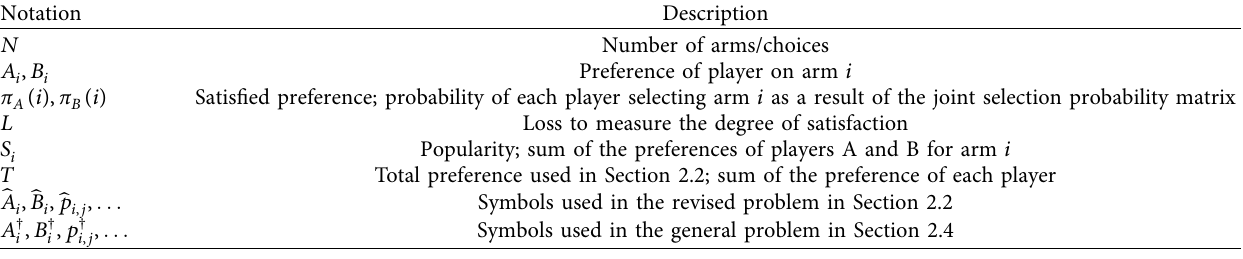
Table 1: Summary of key